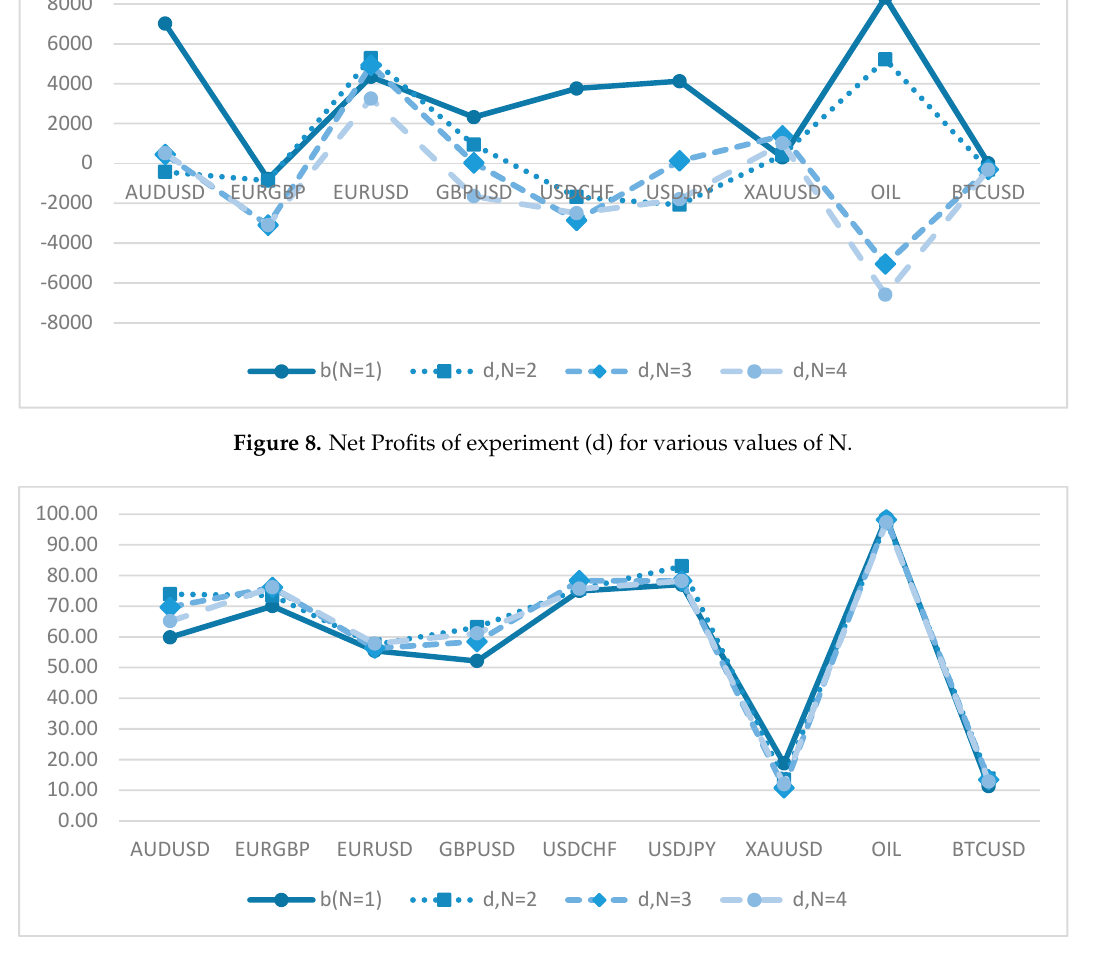
Figure 9. Drawdown, as percentage of equity, of experiment (d) for various values of N.